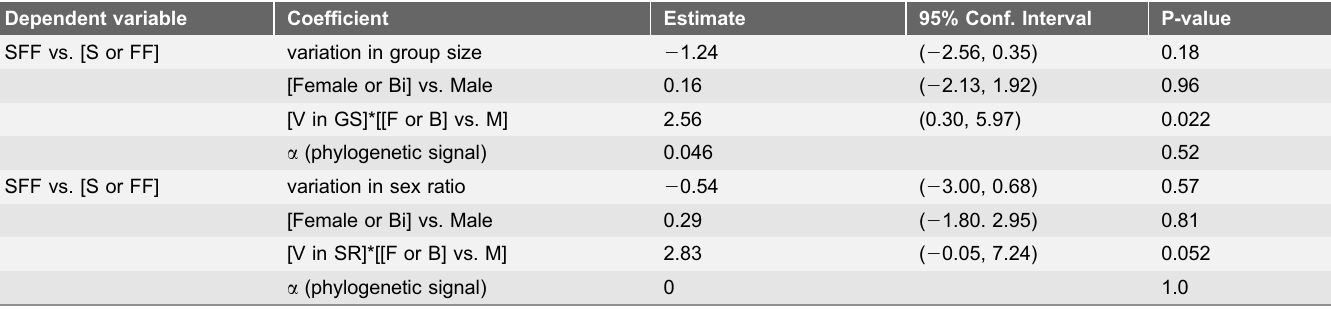
Table 2. Binary phylogenetic regressions of Grouping (SFF vs. not SFF) on Dispersal regime and variation in group size, and on Dispersal regime and variation in adult sex ratio. Dependent